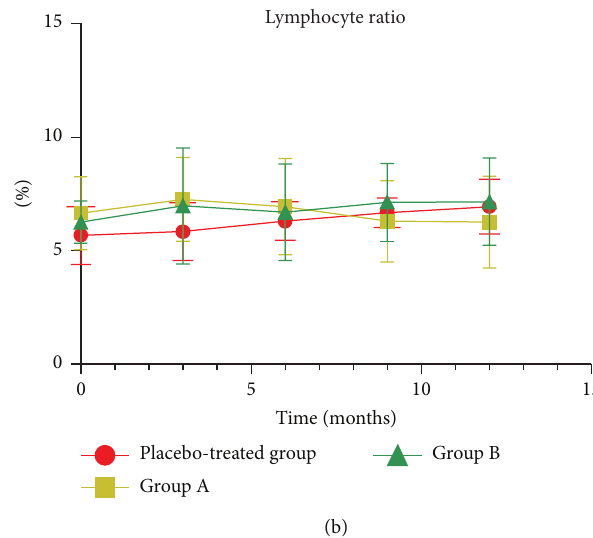
Figure 1: (a) The effects of erythromycin on the number of inflammatory cells in induced sputum (10 6 /mL) in chronic obstructive pulmonary disease patients at baseline and after 3, 6, 9, and 12 months of treatment. There was a significant reduction in total cell counts and neutrophil counts after erythromycin treatment from baseline to 3, 6, 9, and 12 months in group A (all 𝑃 values < .01) and from baseline to 3 and 6 months in group B (all 𝑃 values < .01). There was a significant decrease in total cell counts and neutrophil counts at all time points in group A (all 𝑃 values < .05) and after 3 and 6 months in group B (all 𝑃 values < .05) compared to the placebo-treated group. (b) The effects of erythromycin on the ratio of inflammatory cells in induced sputum (%) in chronic obstructive pulmonary disease patients at baseline and after 3, 6, 9, and 12 months of treatment. Significant reductions in the neutrophil ratio were observed after erythromycin treatment from baseline to 3, 6, 9, and 12 months in group A (all 𝑃 values < .01) and to 3 and 6 months in group B (all 𝑃 values < .01). Compared with placebo-treated group, the significant decreases were also observed in the neutrophil ratio after 3, 6, 9, and 12 months of treatment in group A (all 𝑃 values < .05) and after 6 months in group B ( 𝑃 = .029 ). Increases in the macrophage ratio from baseline to 3, 6, 9, and 12 months in group A (all 𝑃 values < .01) and 6 months in group B ( 𝑃 = .004 ) were observed and compared to placebo; similar increases were significant after 6, 9, and 12 months of treatment with erythromycin in group A (all 𝑃 values < .05) and 6 months in group B ( 𝑃 = .040